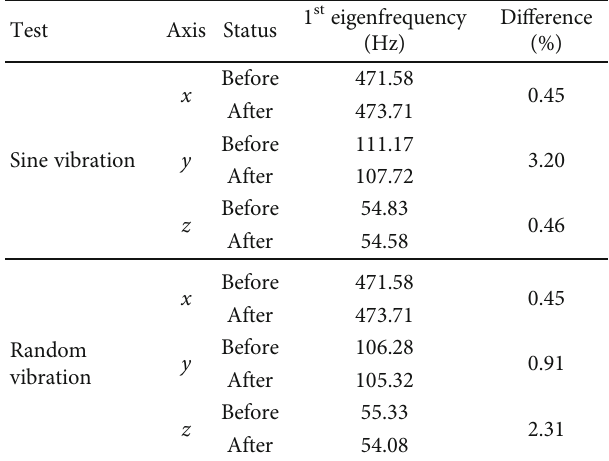
Figure 12: Random vibration test results of solar panel ’ s corresponding axis in the x -, y -, and z -axis excitations. Table 5: LLSS test results of the solar panels before and after full level vibration tests.